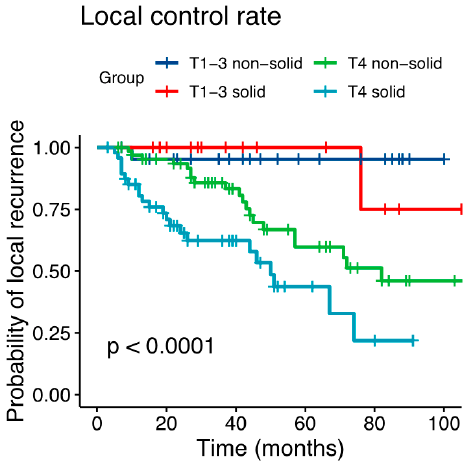
Figure 2. Kaplan-Meier estimates of local control depending on T stage and solid vs. non-solid histology ( p < 0.0001).